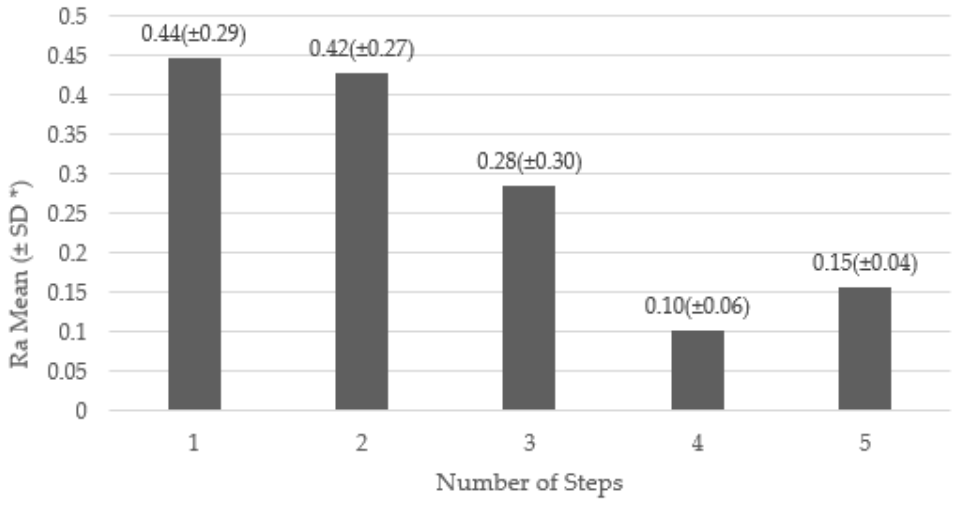
Figure 2. Surface roughness according to number of steps for the polishing systems (PS). Note: Each bar, listed from 1 to 5, represents the mean value (±SD) reached in Ra µm according to the number of steps of the PS. * SD = Standard Deviation.